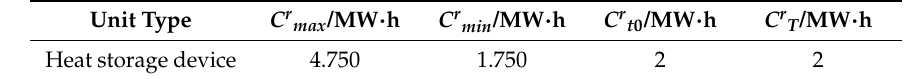
Table 9. Related parameters of heat storage device.